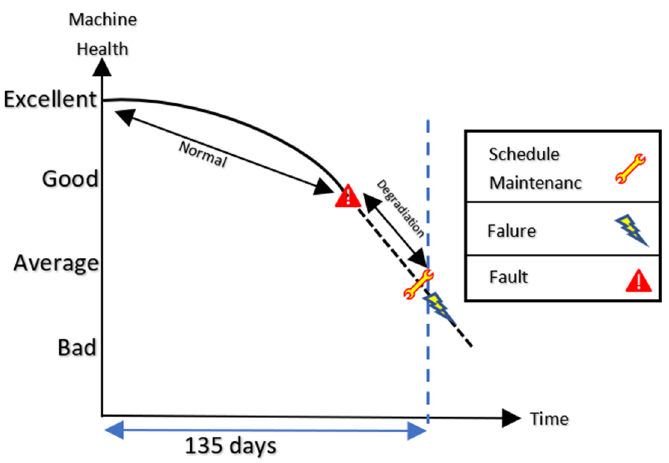
Figure 4. Machinery health conditions in the predictive maintenance model.